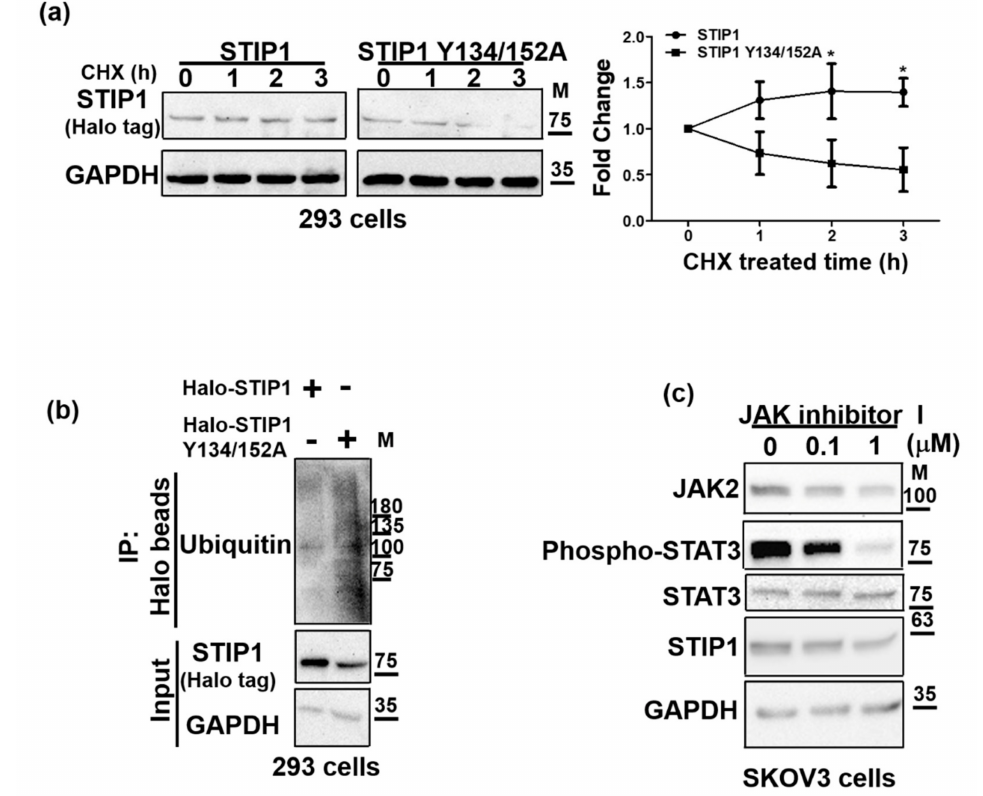
Figure 3. JAK2 regulates STIP1 stability. ( a ) HEK293 cells were transfected with wild-type STIP1 or the STIP1 Y134/152A double mutant (Halo tag) for 48 h and harvested at the reported time points in presence of cycloheximide (CHX). Endogenous GAPDH served as loading control to calculate normalized STIP1 protein levels. Fold changes in protein concentrations for Halo-STIP1 or Halo-STIP1 Y134/152A double mutant are reported in the right panel. Results are expressed as means ± standard errors from three independent experiments. * p < 0.05. ( b ) HEK293 cells overexpressing Halo-STIP1 or the Halo-STIP1 Y134/152A double mutant were harvested after treatment with MG132 (5 µ M) for 12 h. Halo-STIP1 proteins were precipitated with a halo-resin, whereas ubiquitinated proteins were detected with an anti-ubiquitin antibody. Halo-STIP1 protein levels were detected with western blot using GAPDH as input control. ( c ) SKOV3 cells were treated with JAK inhibitor I in the DMEM/F12 medium containing 10% FBS for 48 h. Protein levels of JAK2, phospho-STAT3 Y705, total STAT3, STIP1, and GAPDH were assessed with western